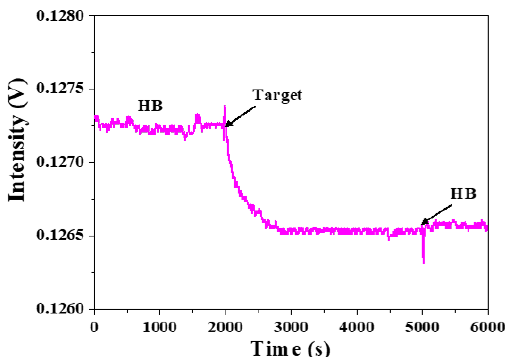
5’ -end in response to 30-mer target H5 ssDNA (n = 5).